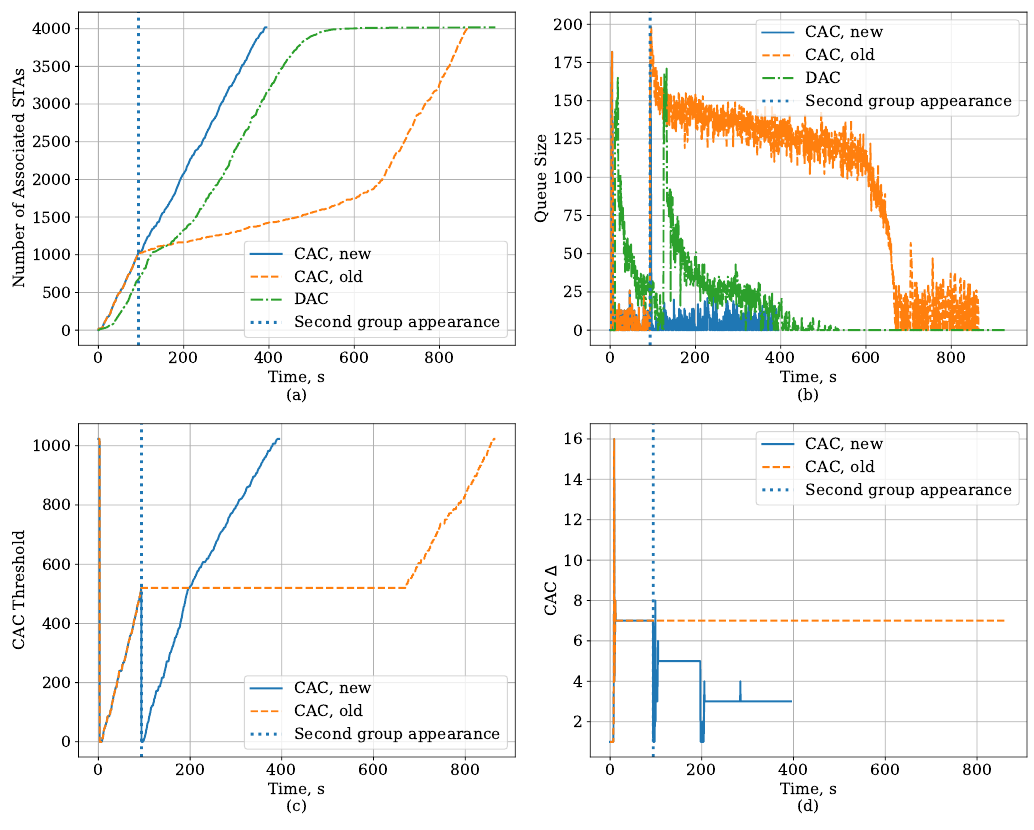
Figure 12. Time dependency of the CAC and DAC protocol parameters for the Large Area case with Capture Effect when new STAs arrive in two groups: ( a ) the number of associated STAs, ( b ) AP queue size, ( c ) CAC threshold, ( d ) the value of ∆ in